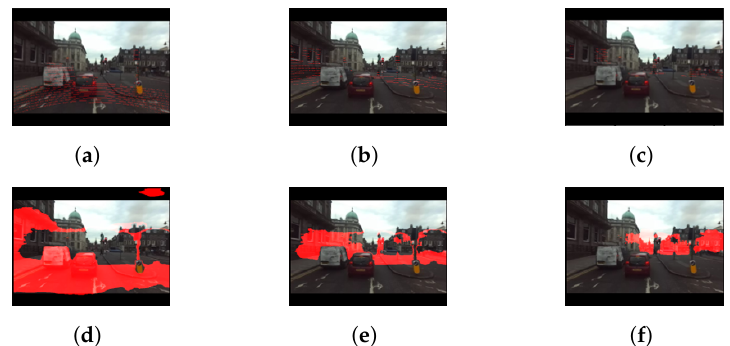
Figure 11. Depth estimation results using RADIATE dataset. ( a ) LiDAR depth 5 to 10 m, ( b ) LiDAR depth 10 to 20 m, ( c ) LiDAR depth 20 to 40 m, ( d ) depth fusion (5 to 10 m), ( e ) depth fusion (10 to 20 m), and ( f ) depth fusion (20 to 40 m).